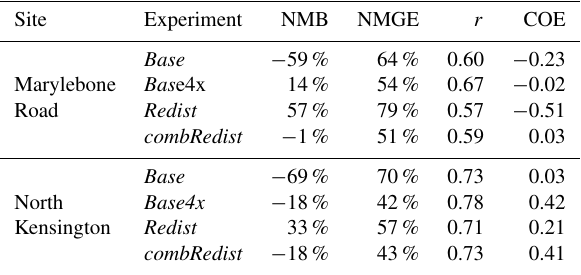
Table 3. Evaluation statistics for modelled vs. measured daily av- erage concentrations of SFOA for the ClearfLo year-long datasets (year